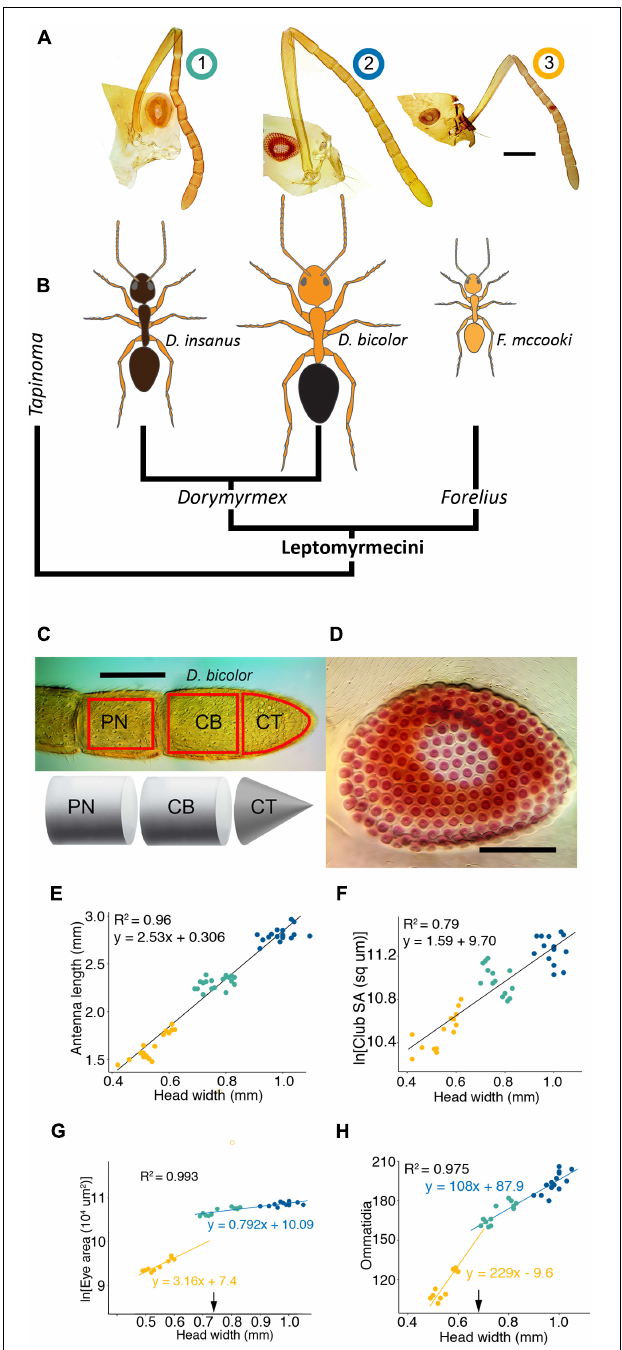
FIGURE 2 | External sensory structures scale with body size. (A) Microphotographs of parts of the head capsule including the eye and antenna of the three focal species arranged by colony size indicated by number rankings above (B) . (B) Phylogenetic relationships among dolichoderine ants included in this study. (C) Sampling area for the three antennal regions (top; red boxes) and diagram of measurements taken for surface area (bottom); penultimate segment = PN; club base = CB; club tip = CT. (D) Photomicrograph of the eye of D. bicolor ; to show ommatidia; eye surface area measured as footprint of eye on head